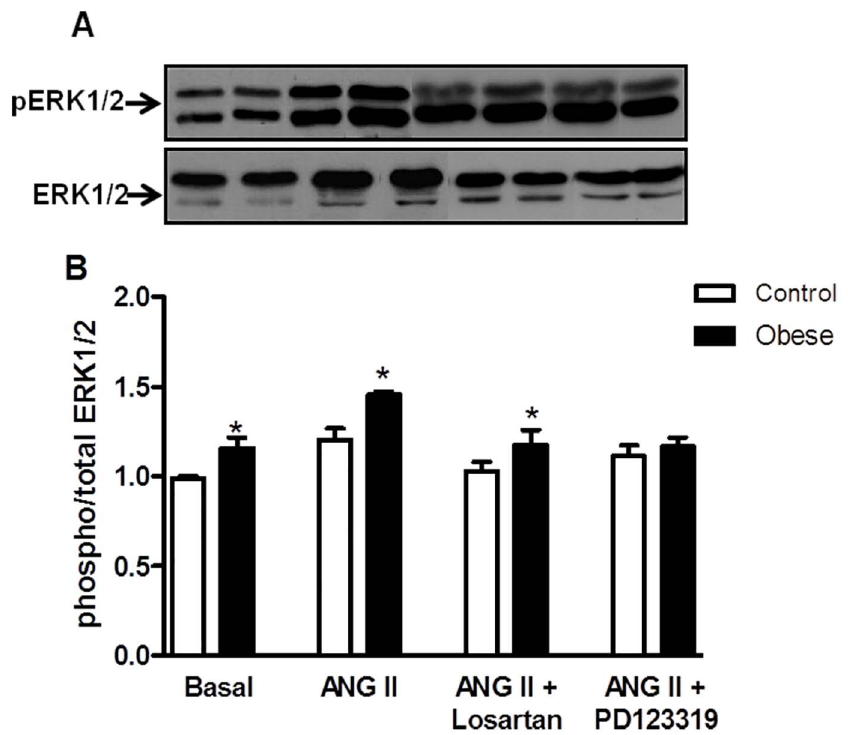
Figure 6. Effects of angiotensin II on ERK 1/2 phosphorylation in mesenteric arteries. Panels show densitometric analysis of the Western blots for ERK1/2 protein expression in endothelium intact mesenteric arteries from control and monosodium glutamate-induced obese rats. Vessels from both groups were stimulated with ANG II (0.1 m mol/L) or vehicle for 10 min in the absence or in the presence of the AT1 receptor antagonist losartan (0.3 m M, 30 min), the AT2 receptor antagonist PD 123319 (1 m M, 30 min) or the ERK1/2 inhibitor PD98059 (1 m M, 30 min) and the phosphorylation of ERK 1/2 was examined. Total protein levels are shown as loading controls. Data are expressed as mean 6 SEM. *, P , 0.05 vs. Control.